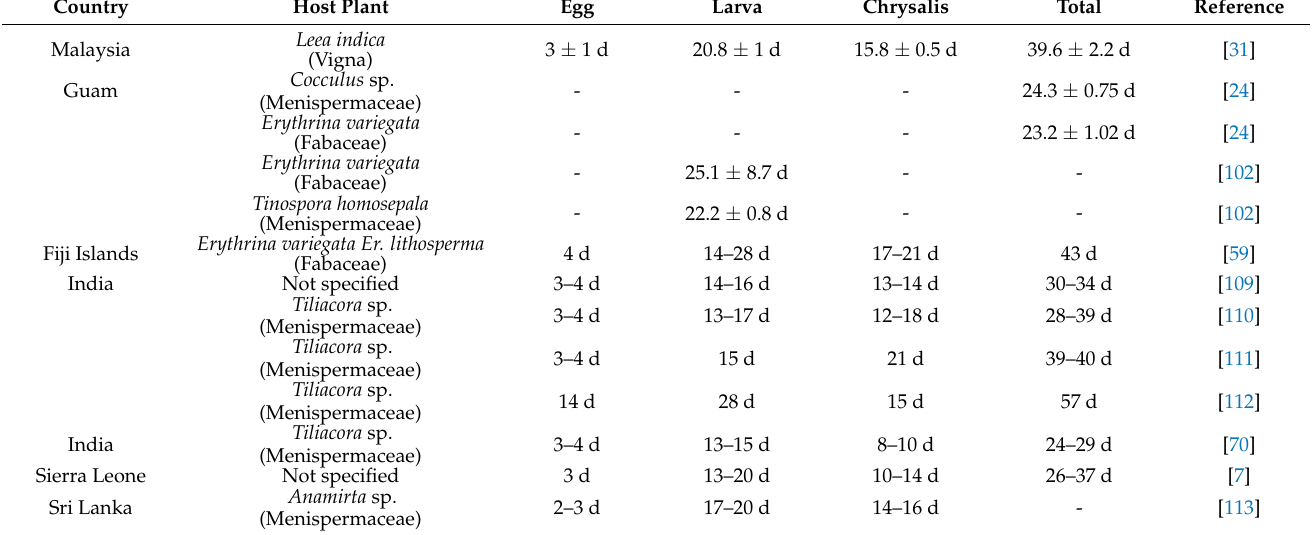
Table 3. Life cycle of Eudocima phalonia according to localities and different